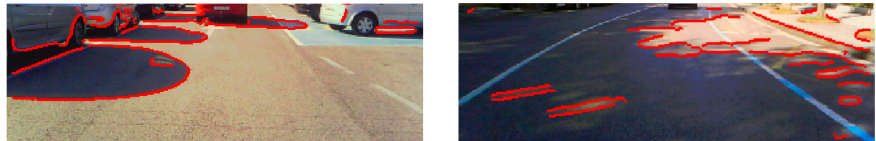
Figure 5. Shadow edge detection obtained by the constraint which relates the red–green and the red–blue proportions of Property 3, i.e., Equation